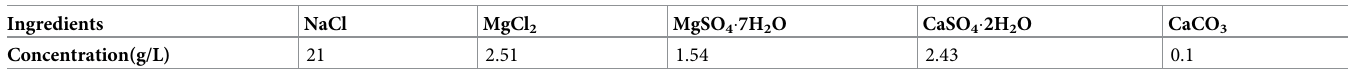
Table 5. Content of various components in natural seawater.